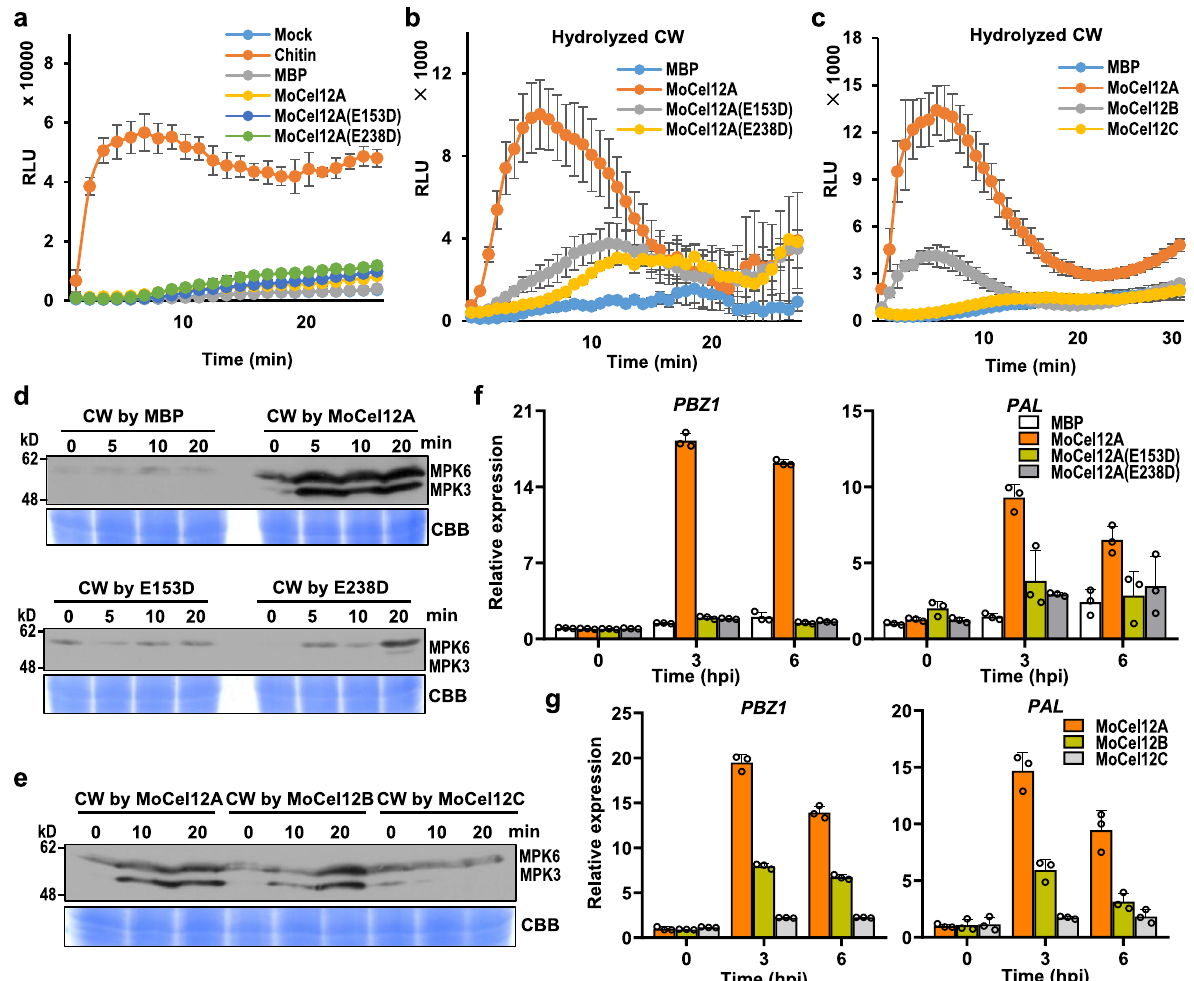
Fig. 3 MoCel12A-hydrolyzed rice cell wall activates an immune response in rice. a MoCel12A and it ’ s variant proteins cannot active ROS burst in rice- suspension cells. Recombinant MoCel12A-His proteins were puri fi ed from Pichia pastoris , and 2 μ g/ml protein each was used for the ROS burst assay. Chitin (1 μ g/ml) served as a positive control. MBP served as a negative control. Values are means ± SD ( n = 4 biological replicates). RLU relative light